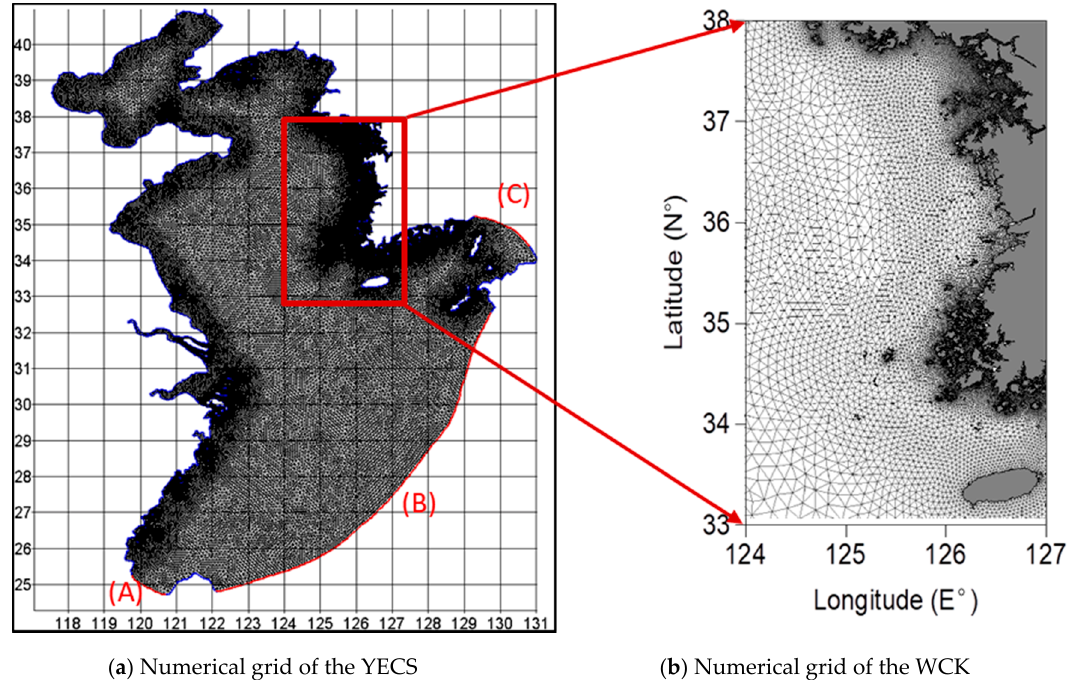
Figure 4. Bathymetry of the YECS Region.